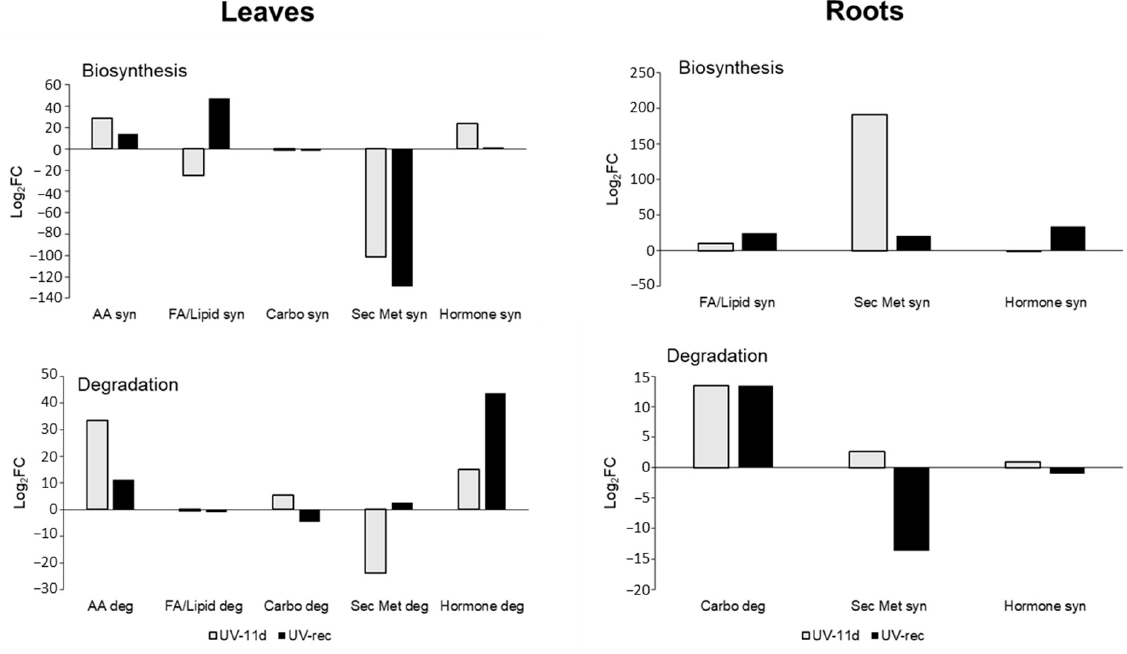
Figure 3. Fold-change (FC) of metabolic processes in leaves and roots of UV treated plants, at 11 days of treatment and after 3 days of recovery, with respect to control plants. FC values were elaborated by the Omics Viewer Dashboard of the PlantCyc Pathway Tool software. Data for each biochemical pathway represent the sum of Log 2 FC of each detected compound. Syn, biosynthesis; Deg, degradation; FA/Lip, fatty acids and lipids; Carbo, carbohydrates; Sec Metab, secondary metabolites; AA, amino acids.